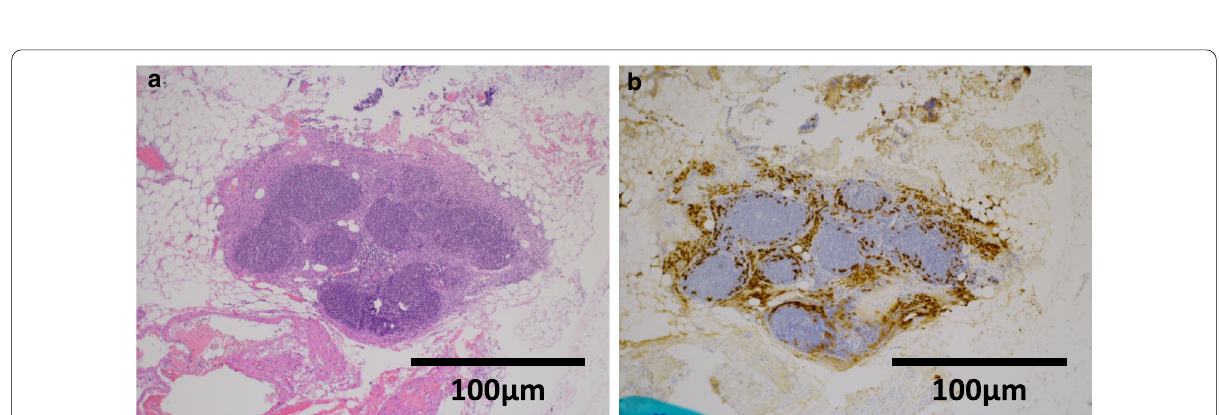
Fig. 5 Microscopic image of metastatic lymph node station No. 5. a HE staining and b immunostaining of pan-cytokeratin (clone: AE1/AE3). Cancer cells are described as pan-cytokeratin (clone: